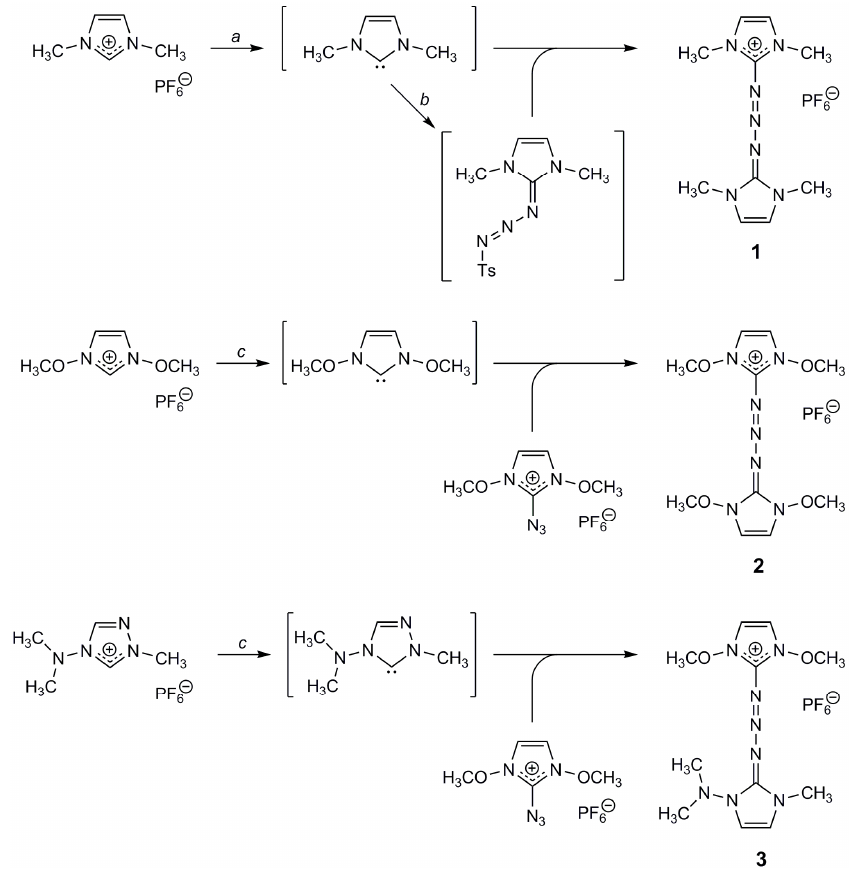
Figure 1. Synthesis of 1 – 3 . Reagents and conditions: a : Li(Me 3 Si) 2 N, THF; b : TsN 3 ; c : NaH, CH 3 CN.